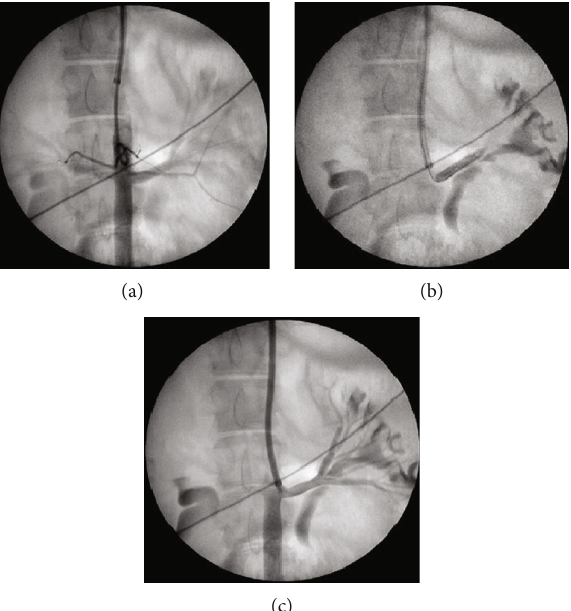
Figure 1: Ablation of the left RA: pig no. 3. (a) RA angiography using a pigtail catheter. (b) In fl ation of a RF balloon with complete obstruction of the left main RA. (c) Repeat angiography of the RA after ablation. A slight RA lumen narrowing can be seen. RA: renal artery; RF: